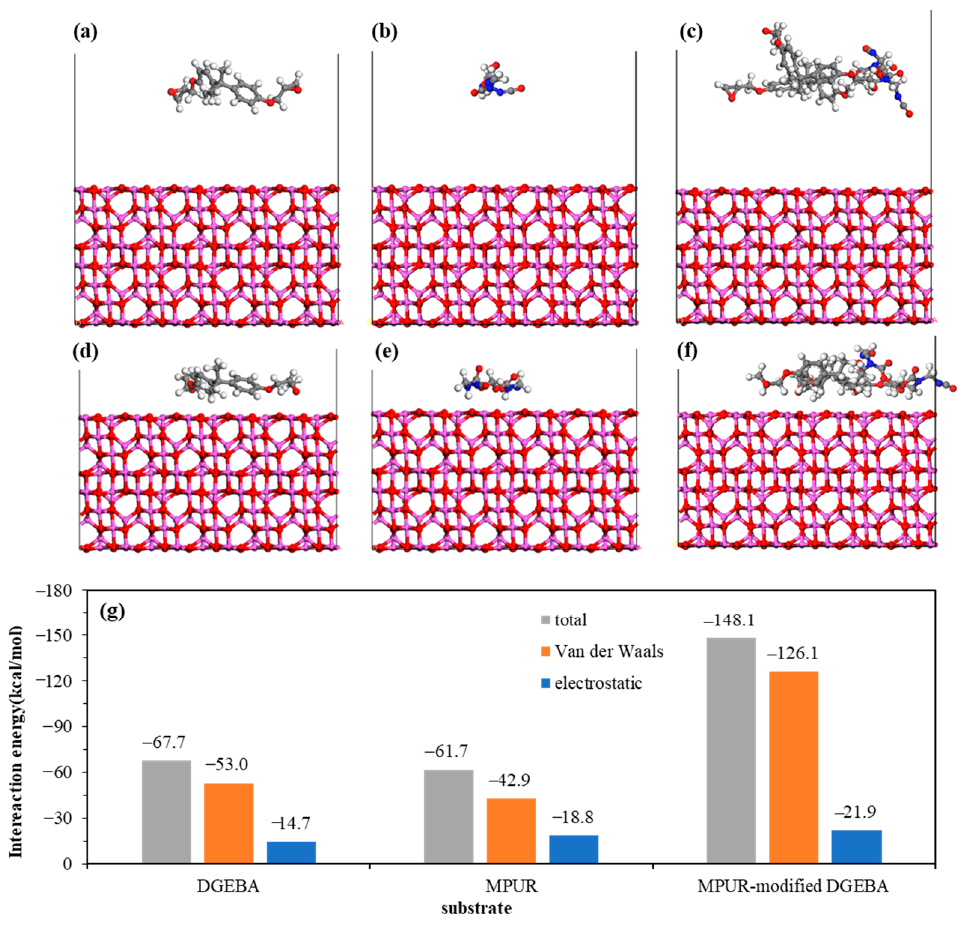
Figure 7. Molecular structure of Al 2 O 3 (100) surface before and after interaction with ( a , b ) DGEBA, ( c , d ) MPUR, and ( e , f ) MPUR-modified DGEBA, and ( g ) their adsorption energy. The molecular structures and adsorption energies of DGEBA, MPUR, and MPUR- modified DGEBA on the MgO (100) surface before and after adsorption are shown in Figure 8. After adsorption, all three adsorbents are found to be in close proximity to the MgO substrate. However, unlike on the ZnO (10-10) and Al 2 O 3 (100) surfaces, the longitudinal size of MPUR-modified DGEBA did not decrease significantly after adsorption on the MgO (100) surface, indicating that its infiltration into the MgO surface is lower. The nonbonded interaction energies of DGEBA, MPUR, and MPUR-modified DGEBA with the ZnO (10-10) surface are − 40.7 kcal/mol, − 61.6 kcal/mol, and − 89.2 kcal/mol, respectively. Compared with DGEBA, the MgO (100) surface shows a stronger preference for the ad- sorption of MPUR due to its electrostatic force. Furthermore, the di ff erence in interaction energy between DGEBA and MPUR on the MgO (100) surface (51.4%) is signi fi cantly higher than that on the ZnO (10-10) (12.8%) and Al 2 O 3 (100) (8.9%) surfaces, indicating a more obvious preference for MPUR adsorption on the MgO (100) surface. However, as previously analyzed, the adhesion force of the adhesive on the coating surface is not only directly determined by the nonbonded interaction but also by chemical interaction.